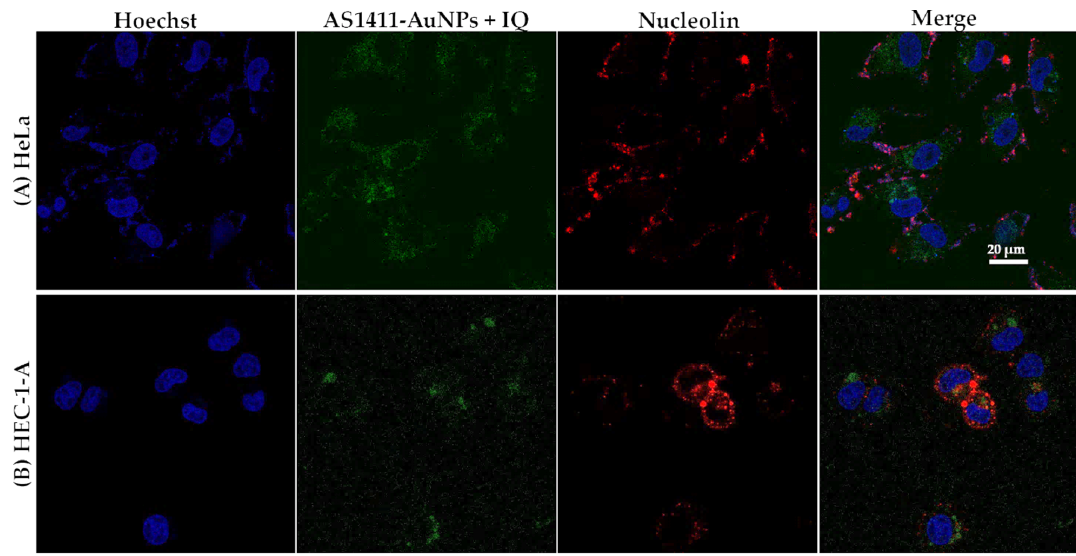
Figure 7 . Confocal fluorescence images of ( A ) HeLa and ( B ) HEC-1-A cells incubated with AS1411-gold nanoparticles with IQ for 15 min at 37 °C. Nucleolin is stained with AlexaFluor 647 ® (red), IQ emits green fluorescence. Cell nuclei are stained with Hoechst 33342 (blue). Scale bar: 20 µm.